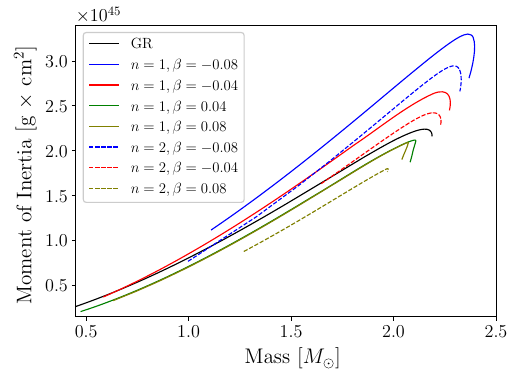
Fig. 3 Moment of inertia-mass relations for the APR4 EOS and differ- entvaluesof β forthecouplingfunction(11). n = 1solutionsareshown with solid lines while n = 2 solutions are indicated with dashed lines of the same color. These are the same branches of solutions depicted in Fig. 1